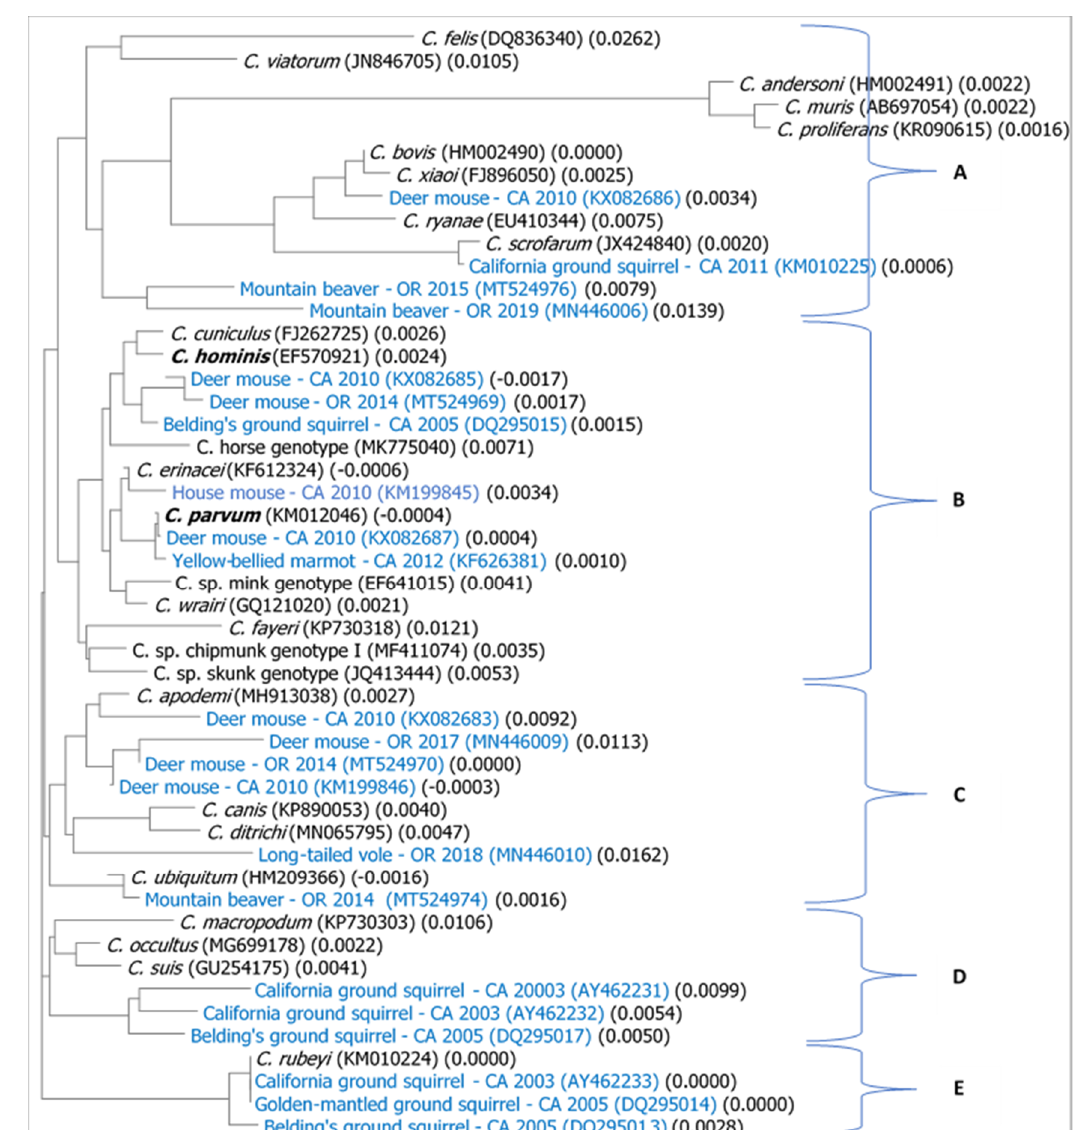
Figure 2. Phylogenetic relationship between relatively recent Cryptosporidium isolates from wild rodent species from the west coast of the US ( blue font ) and a collection of representative Cryptosporidium species from mammals and selected zoonotic genotypes ( black font ). Given their importance in human infection, C. homonis and C. parvum are in bold.